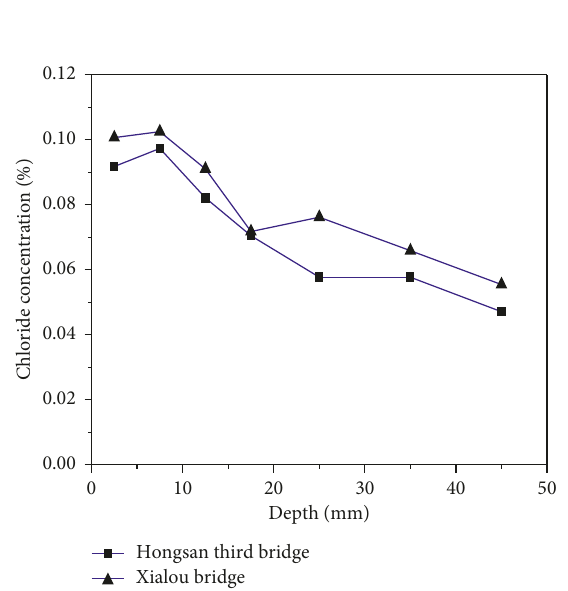
Figure 10: Comparison of the chloride profile between Xialou bridge and Hongsan Third bridge.